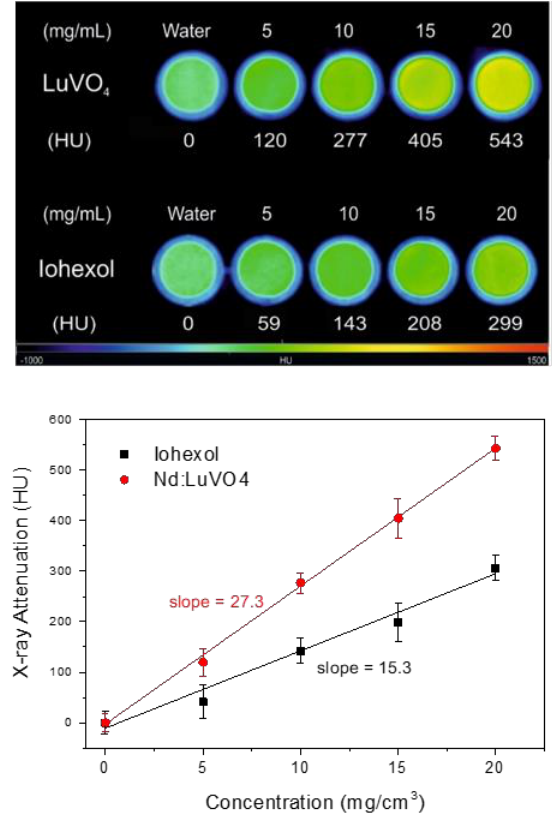
Figure 7. X-ray attenuation phantom images ( top ) and Hounsfield units (HU) values ( bottom ) obtained for the Nd (1.5%):LuVO 4 nanoparticles and for Iohexol at different concentrations in water.